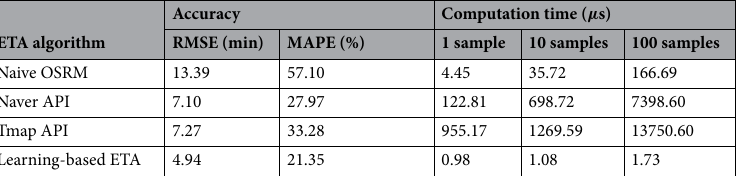
Table 2. Performance comparison of Estimated Time of Arrival (ETA): The proposed learning-based ETA model is incredibly fast compared to others while maintaining similar accuracy.